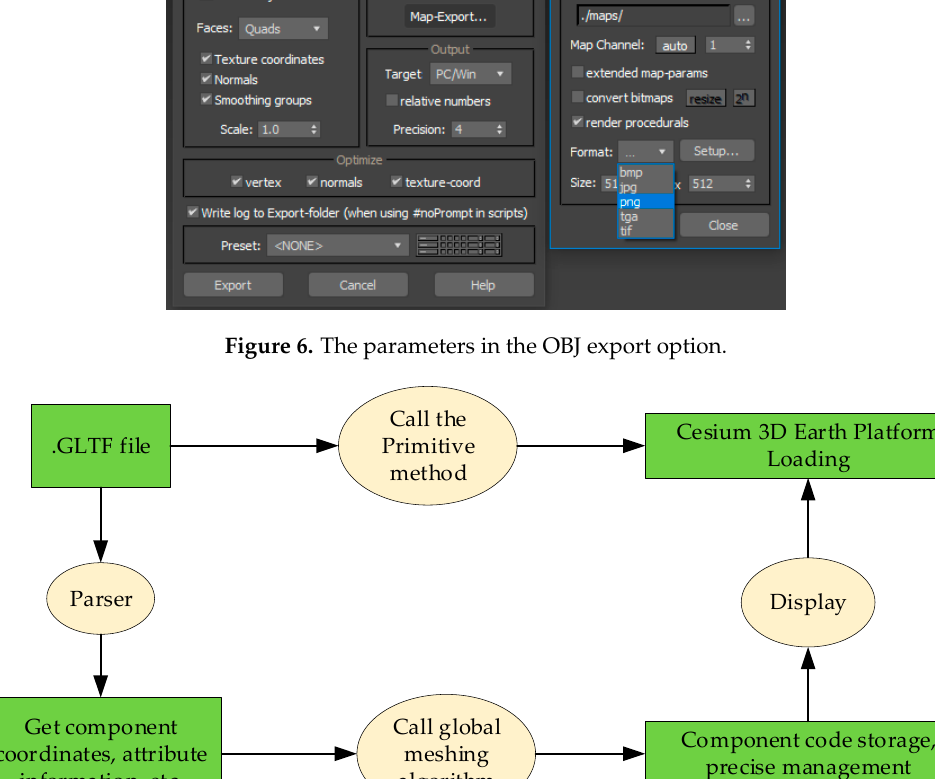
Figure 6. The parameters in the OBJ export option.